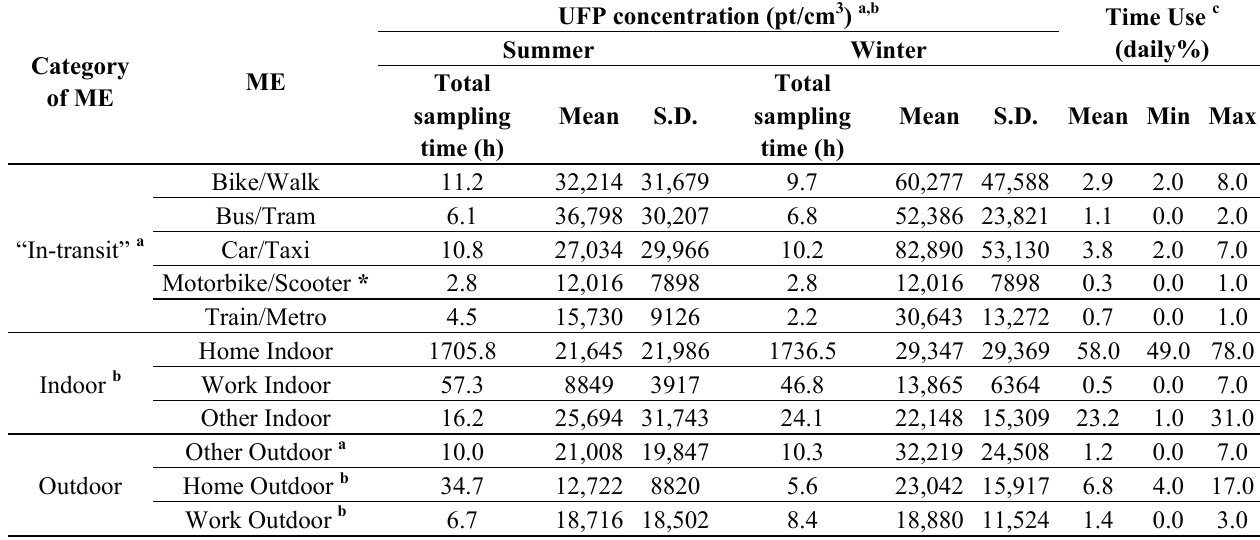
Table 2. Microenvironments used for the exposure simulation, total sampling time (h), UFP environmental concentrations for summer and winter (mean, standard deviation) (particle/cm 3 ), and time-activity patterns (daily percentage of the typical working